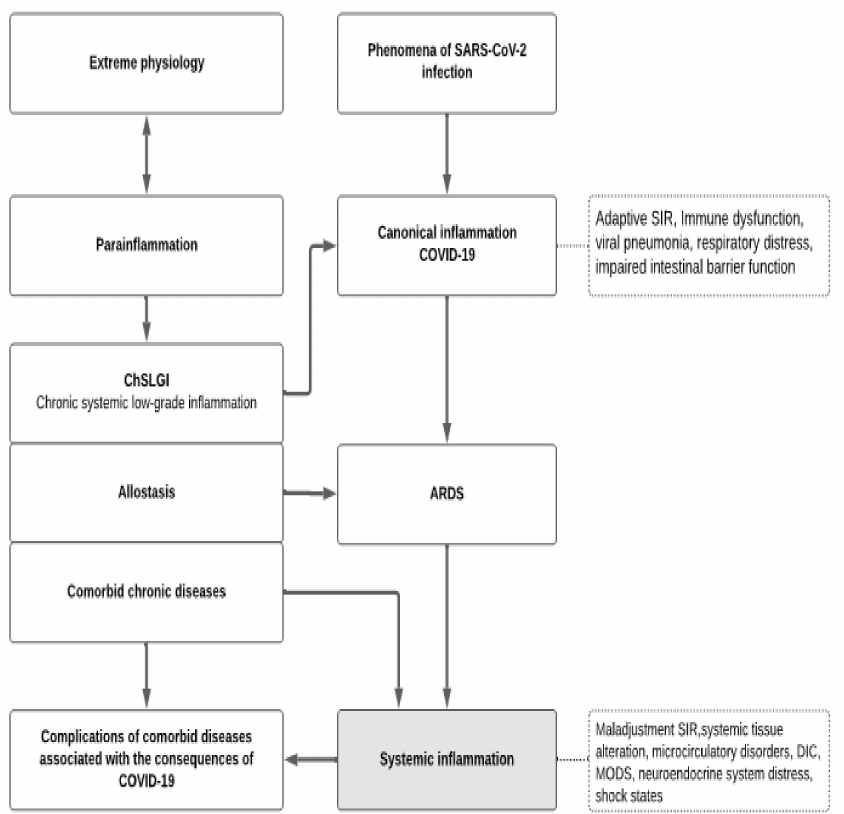
Figure 3. The relationship of general pathological processes in COVID-19. Two interrelated processes are depicted in the heuristic diagram of COVID-19 pathogenesis. In the left part of the scheme, the development of comorbid chronic pathologies, risk factors for SARS-CoV-2 infection, and chronic systemic low-grade inflammation (ChSLGI), which is a common, typical pathogenetic basis of chronic pathologies (in the form of allostasis), as well as comorbid chronic diseases are depicted. ChSLGI is linked to pro-inflammatory tissue stress, a subthreshold for the formation of focus of classical inflammation processes, and life-threatening “systemic inflammatory microcirculation”. In the center, the transformation of canonical pneumonia into Acute Respiratory Distress Syndrome (ARDS), which is already a sign of systemic inflammation (SI), is described. The source for ChSLGI development and stabilization (in the form of allostasis) are the extreme physiological processes in which tissue stress has limitations in its severity, time, and prevalence in the